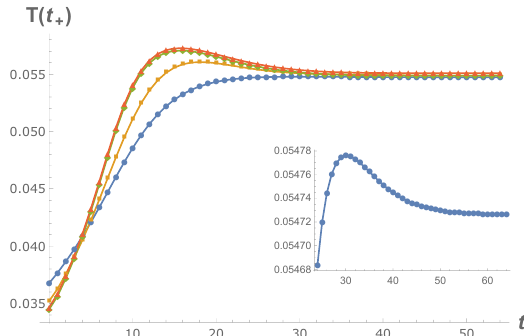
Figure 4. Plots of the effective temperature as a function of t + starting from different states and for different µ . The quenches have been tuned so that the final inverse temperature is β ∼ 18 . All the quenches are performed with time dependent q = 4 SYK interaction except for the red curve which was with time dependent q = 6 SYK interaction. The blue curve is for µ = η = 0 . The inset shows the non-monotonicity of the effective temperature for this case. The orange curve is for initial state with η = 0 . 24 . The green curve is for initial state η = 0 but with µ = − 0 . 263 . The red curve is for the same initial state as the green curve but the time dependent perturbation was ( q = 6)